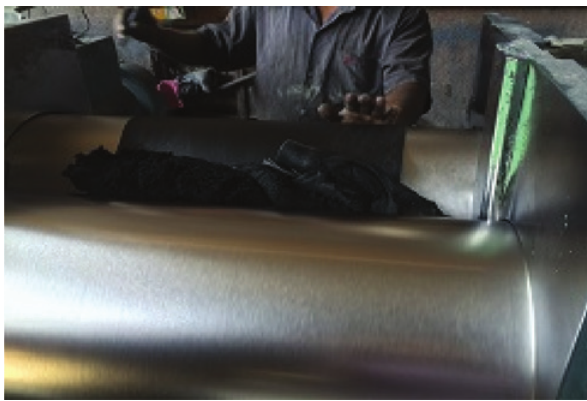
Figure 3: Two roll laboratory mill.